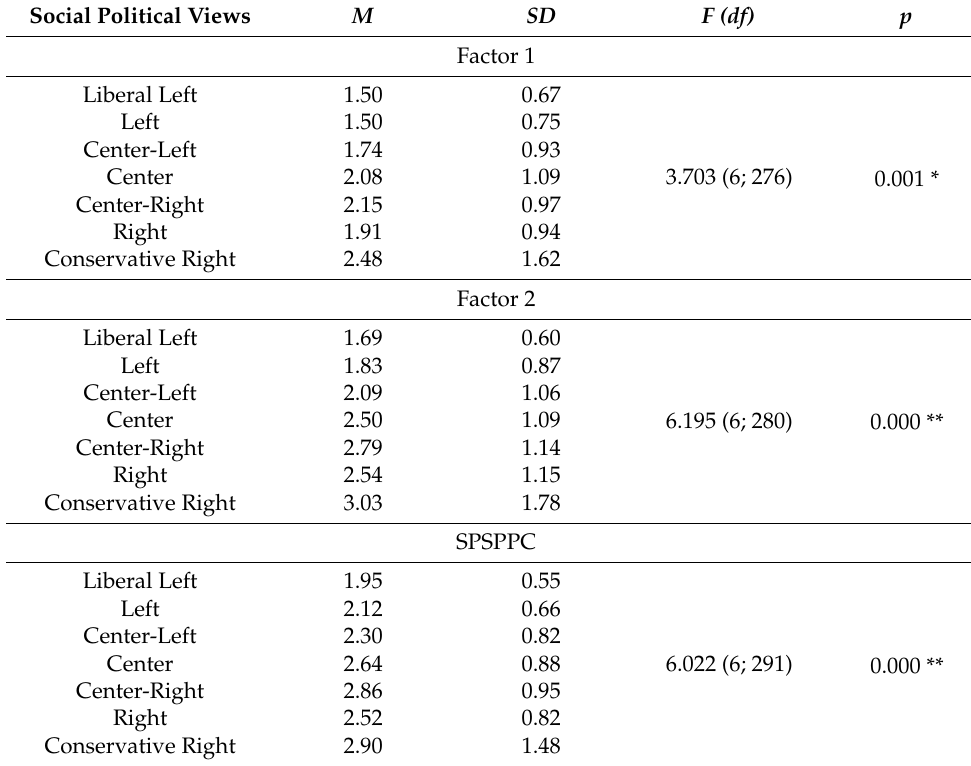
Table 7. Sexual prejudice levels by social political views.